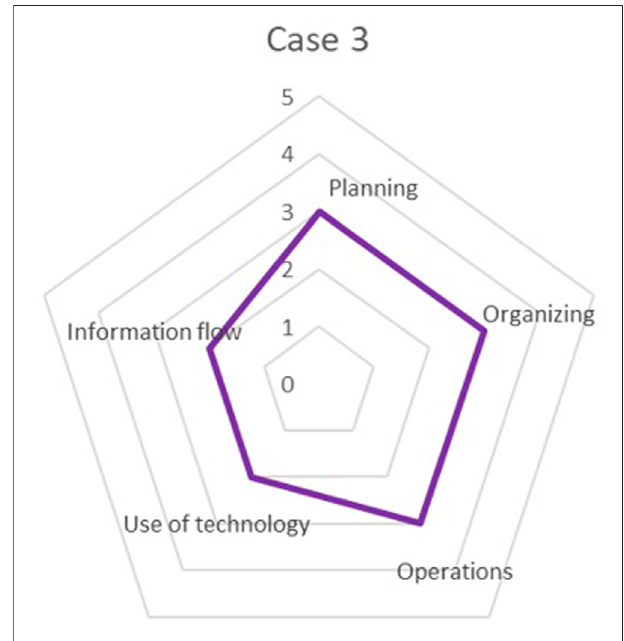
FIGURE 5 | Case 3 ’ s logistics maturity